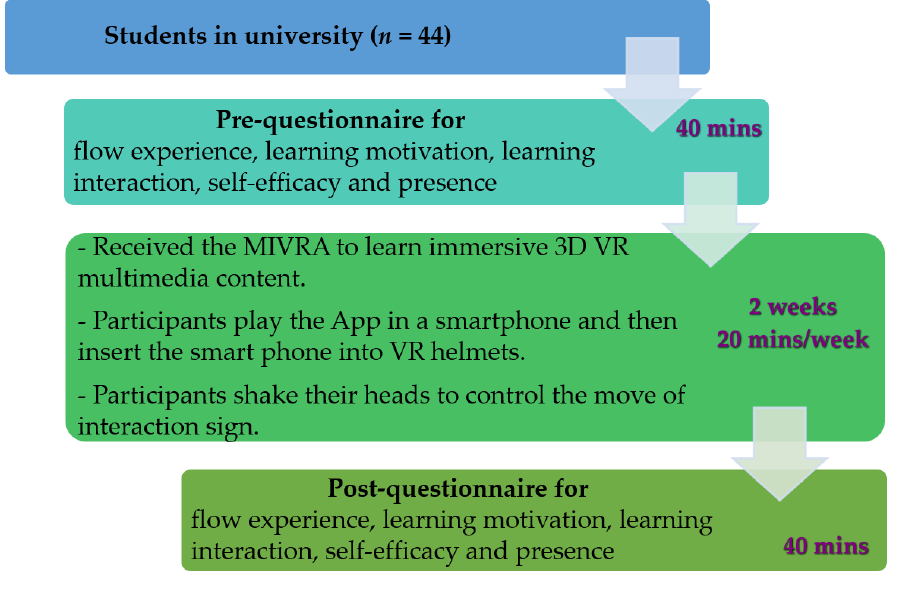
Figure 13. The 2-week experimental process. Table 4. Measurement sources and numbers of